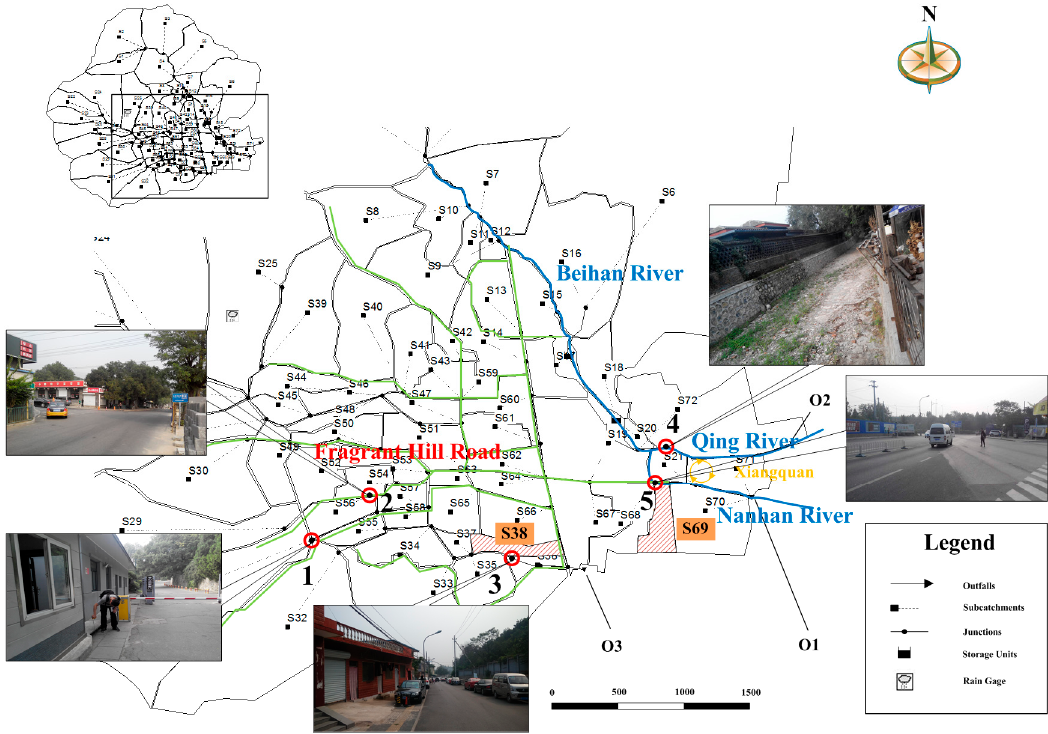
Figure 4. Distribution of the ISI positions.